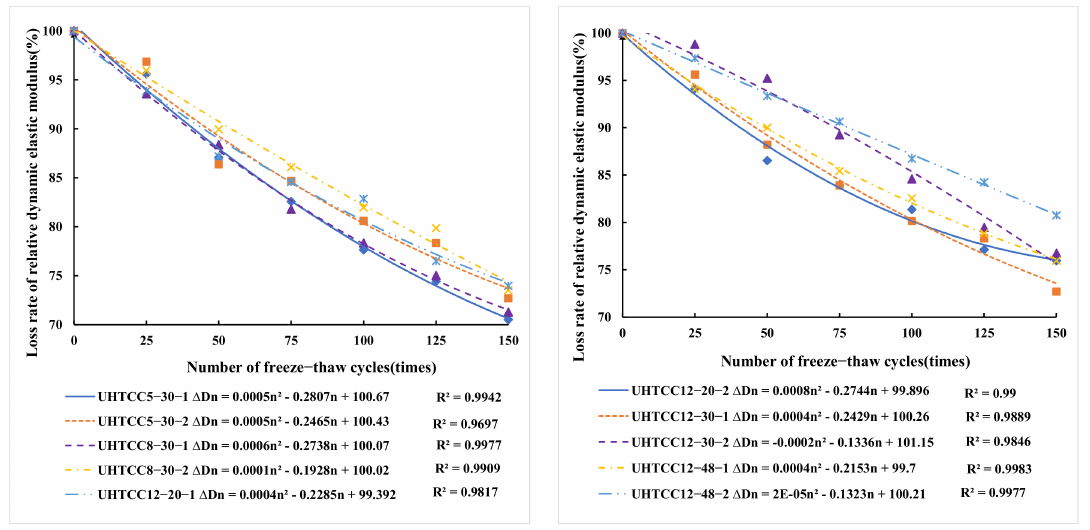
Figure 6. Relative dynamic elastic modulus damage under different number of freeze–thaw